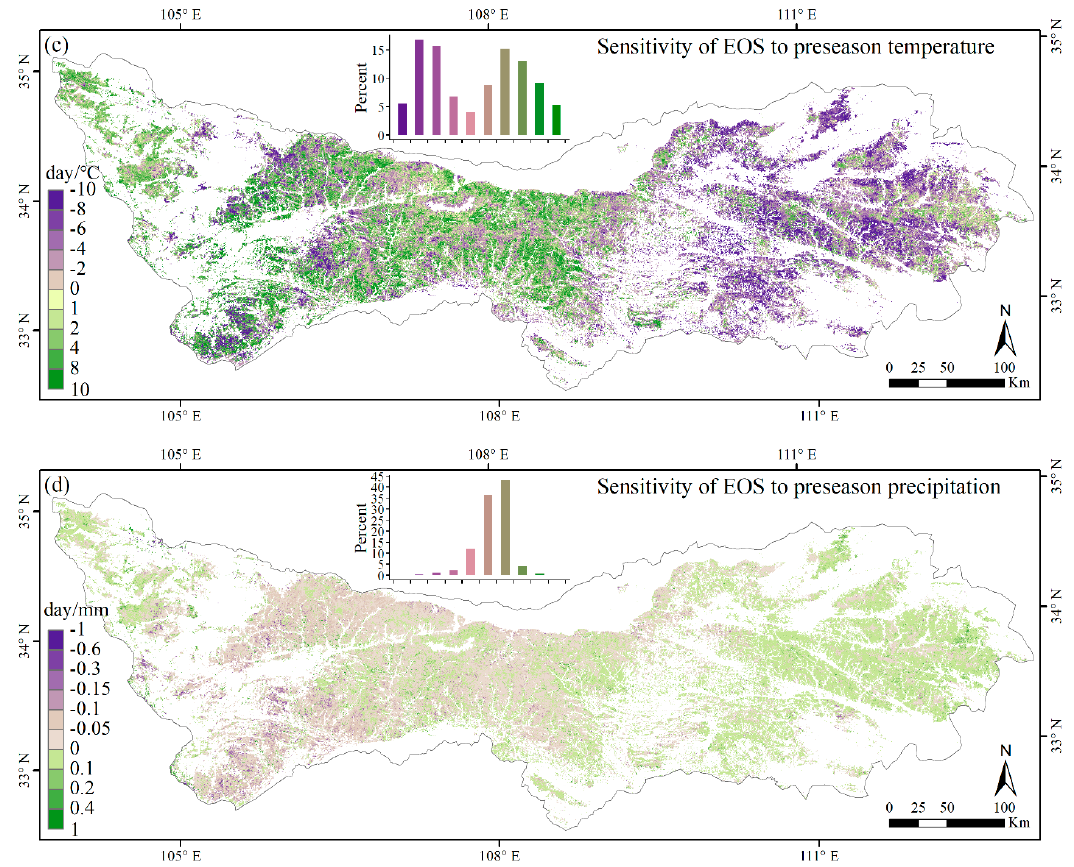
Figure 8. Spatial patterns of the sensitivities of the SOS (EOS) to preseason mean temperature and accumulated precipitations in the QMs during 2001–2017: ( a ) the sensitivities of the SOS to preseason mean temperatures; ( b ) the sensitivities of the SOS to preseason accumulated precipitation; ( c ) the sensitivities of the EOS to preseason mean temperatures; ( d ) the sensitivities of the EOS to accumulated precipitation.